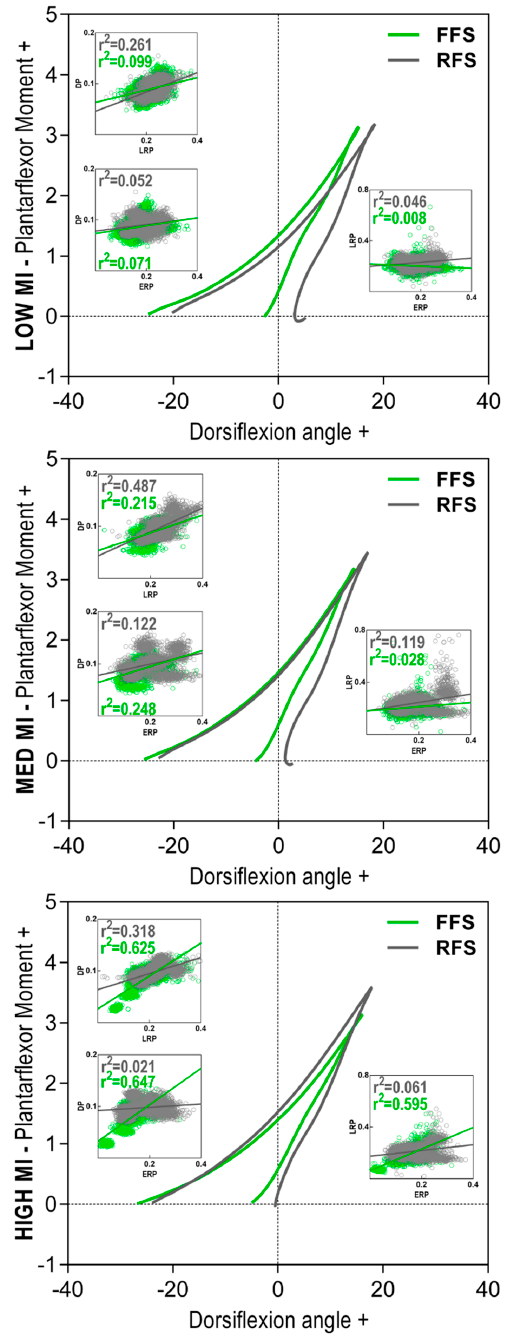
Figure 3. Ankle moment–angle plot. Group mean profiles comparison for low-MI, medium-MI and high-MI shoes. Insets report linear regression lines among early rising phase (ERP), late rising phase (LRP) and descending phase (DP).